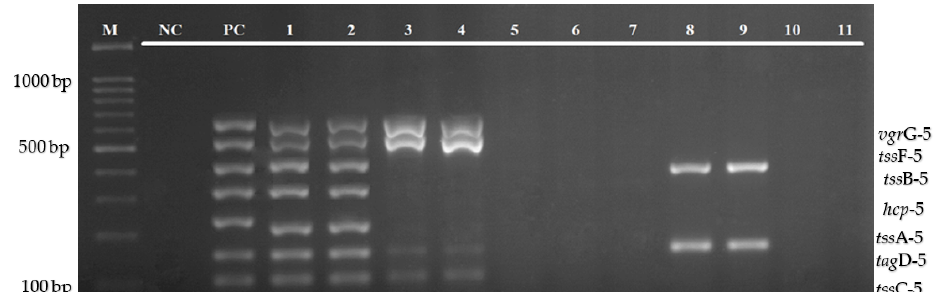
Figure 7. Evaluation of multiplex PCR using environmental isolates of B. pseudomallei and other species of Bukrholderia. Lane M: 100bp DNA Ladder; NC: negative control; PC: positive control; lanes 1–2: B. pseudomallei ; lanes 3–4: B. thailandesis ; lane 5: B. ubonensis ; and lanes 6–11: B. stagnalis .